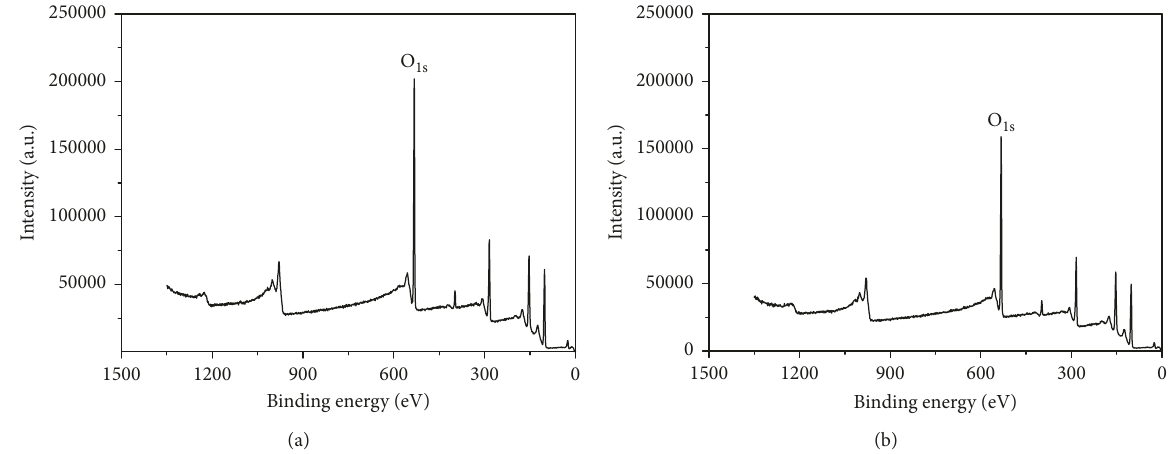
Figure 2: XPS spectra of SiC whiskers (a) before and (b) after surface modification.